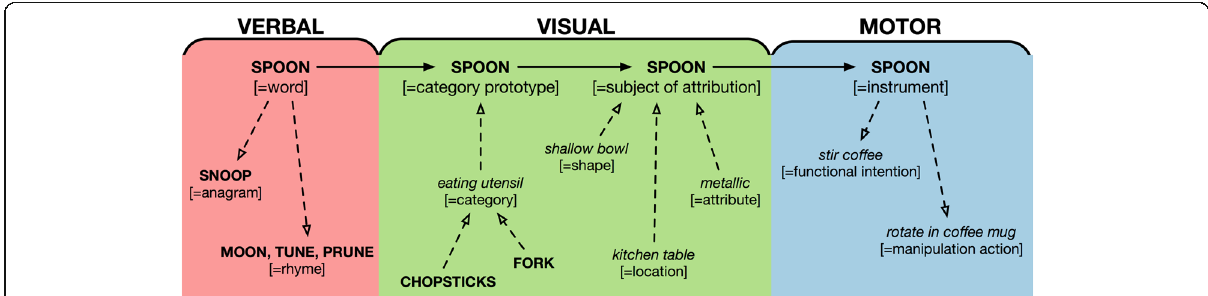
Fig. 7 Example of word properties associated with visual, verbal, and motor coding for the word “ SPOON ” . A word can evoke multiple types of representation ( “ codes ” in dual coding theory). Viewing a word will automatically evoke verbal representations related to its component letters and phonemes. Words representing objects (i.e., concrete nouns) will also evoke visual representations, including information about similar objects, component parts of the object, and information about where the object is typically found. In some cases, additional codes can also be evoked, such as motor-related properties of the represented object, where contextual information related to the object ’ s functional intention and manipulation action may also be processed automatically when reading the word. Copyright note: this figure was produced by the authors and is based on Aylwin (1990; Fig. 2) and Madan and Singhal (2012a, Fig.